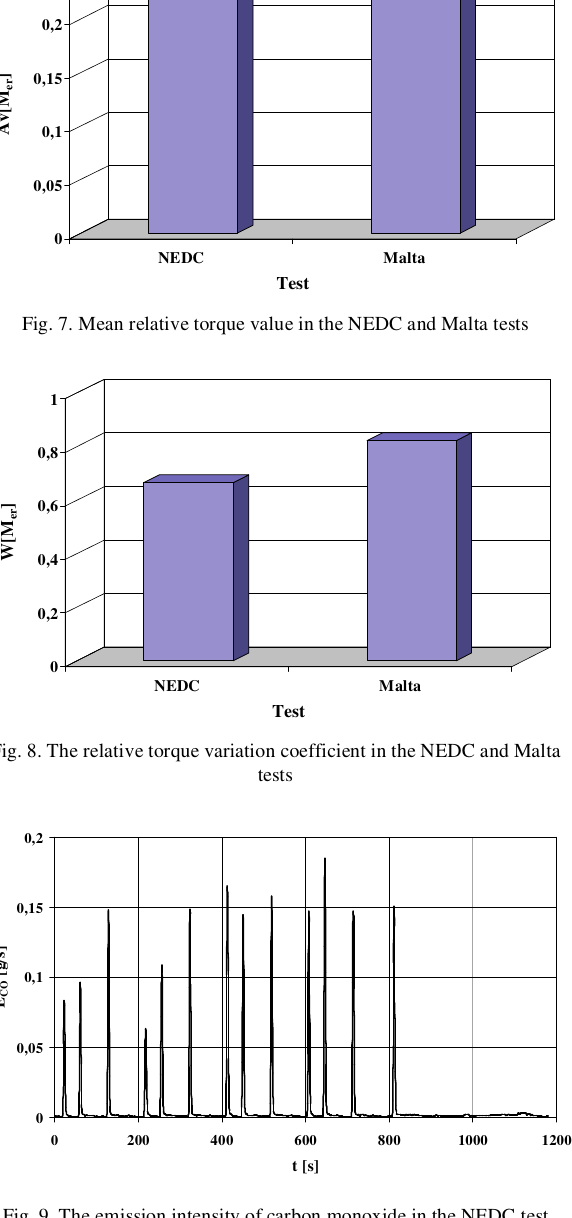
Fig. 9. The emission intensity of carbon monoxide in the NEDC test